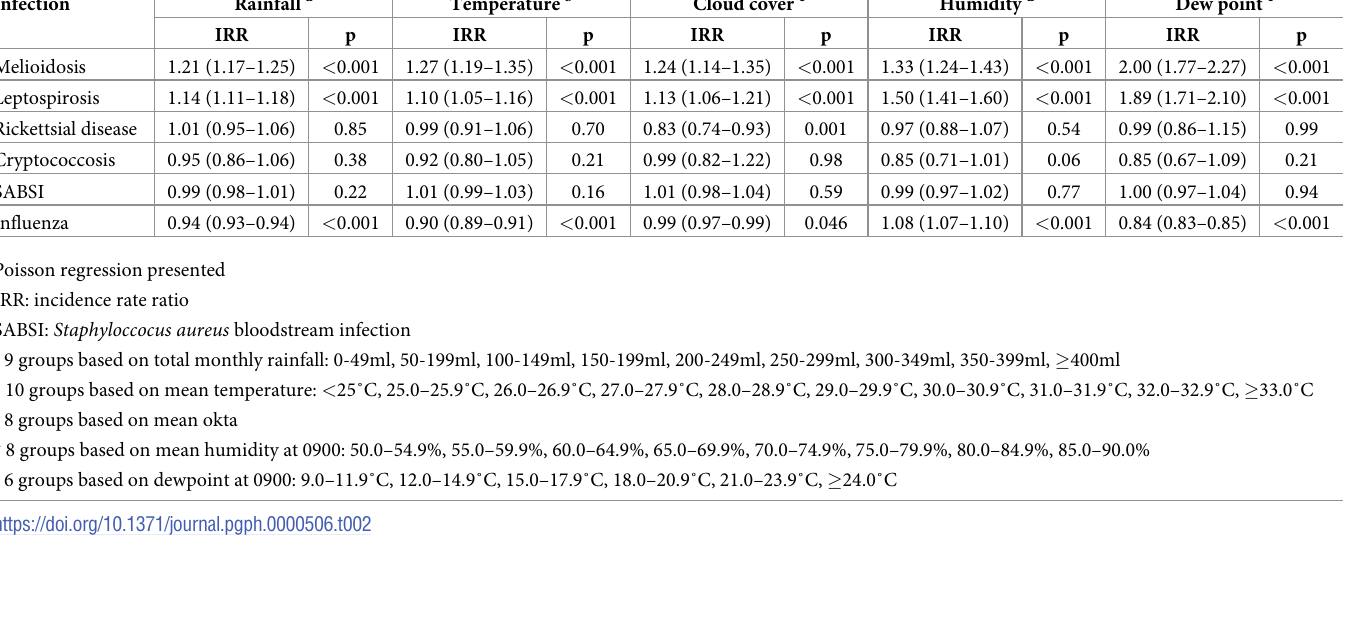
Table 2. Association of individual climatic factors with the different infections in Far North Queensland, 1998–2019. Infection Rainfall a Temperature